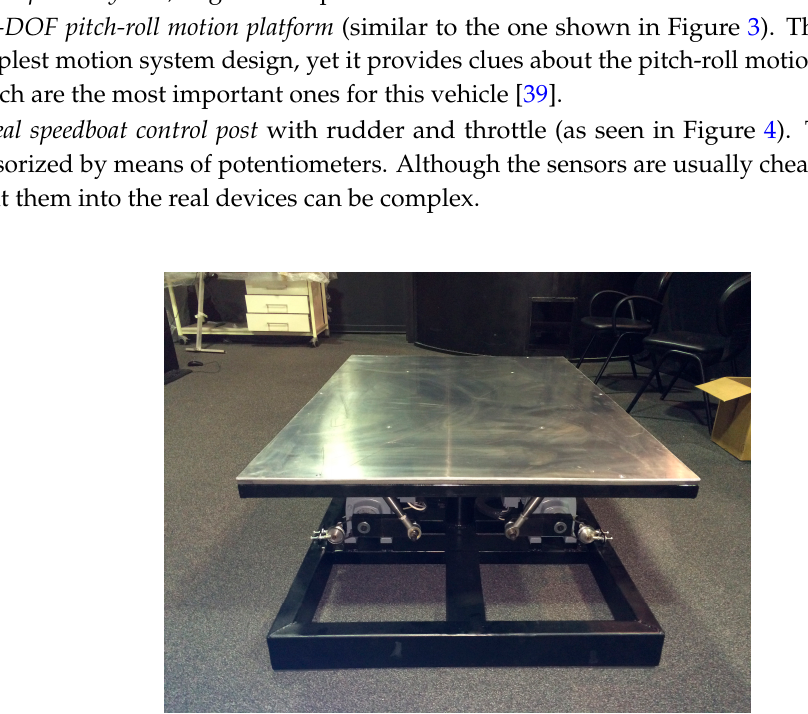
Figure 4. Example of vehicle controls for the speedboat simulator.